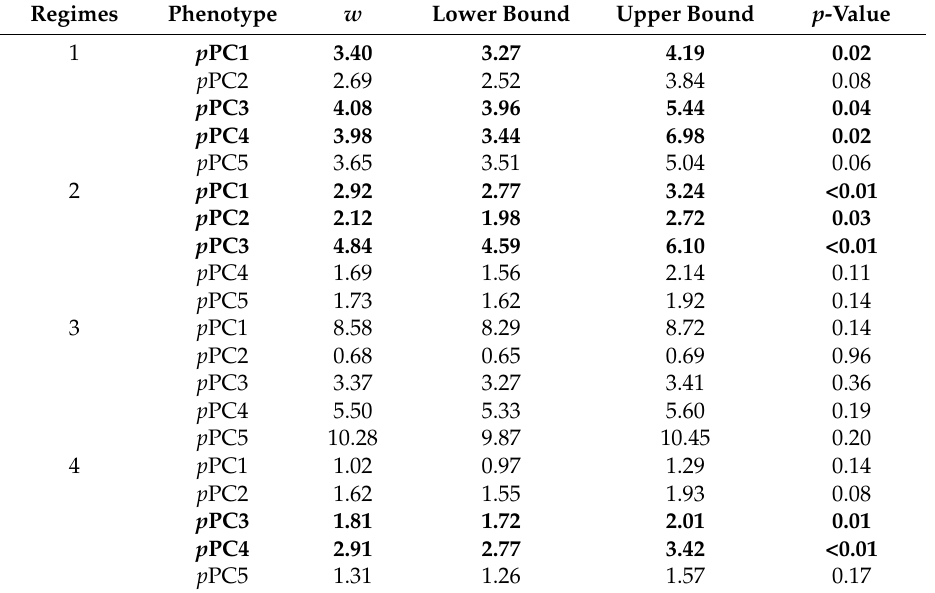
Table 2. Wheatsheaf indices ( w ) with associated 95% confidence intervals for shape variables of jaw in each convergent regime. Wheatsheaf indices ( w ) with associated 95% confidence intervals for shape variables of skull in each convergent regime. p -values from analyses are also provided, and significant ( p < 0.05) values are highlighted in bold. Factor loads indicated that p PC1 represented jaw size, p PC2 represented relationship between dentary depth, p PC3 represented relationship between condyle height and mandibular toothrow length, p PC4 represented condyle to last molar distance and p PC5 represented relations between dentary depth under first molar and coronoid process height.